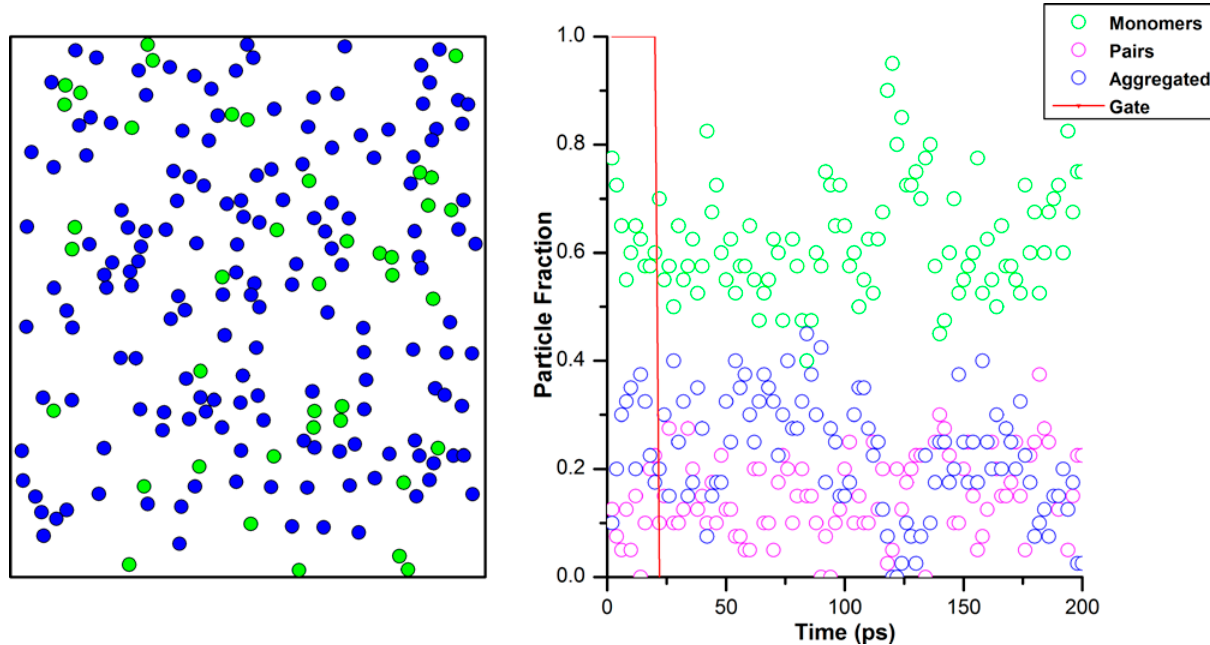
Figure 8. Left: snapshot of the configuration obtained after 200 ps of a simulation started from the configuration shown in Figure 3 at T = 500 K. The interaction parameters (eV) were: ɛ A-A = 0.01, ɛ B-B = 0.1 and ɛ A-B = 0.05. Right: time evolution of the fraction of B monomers, pairs of B atoms and total aggregated B atoms present in clusters of more than 2 B atoms for the same simulation. The time at which the red line sharply drops to zero indicates when the gate shown in Figure 3 was opened and the particles were allowed to mix. The MD time step was 1